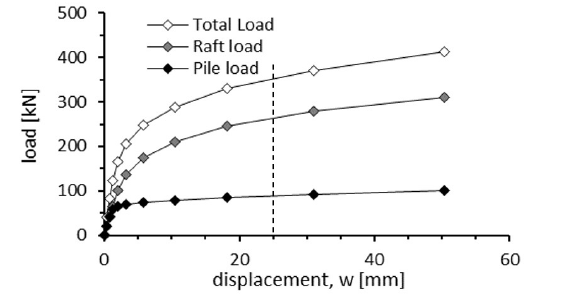
Figure 15. Load-settlement curves for case 8 - L=4m; t=0.4m